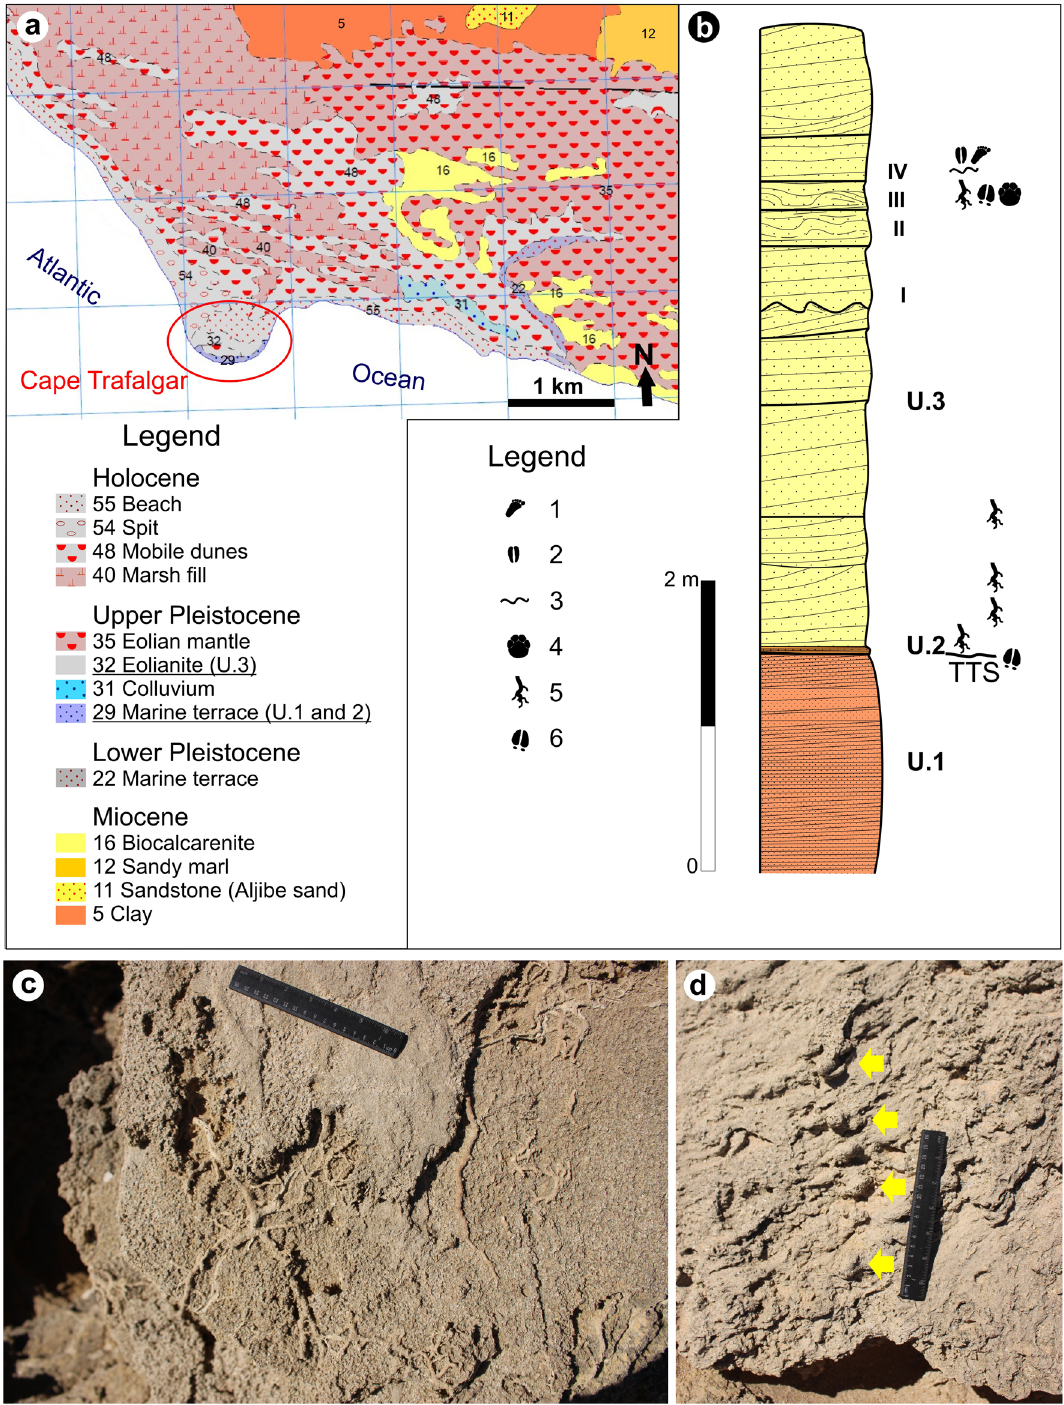
Figure 2. Stratigraphy of the TTS in Cape Trafalgar (Province of Cadiz). ( a ) Geological map of the Cap Trafalgar area (adapted from the Geological Map of Spain 1:50,000, Map no.1073 Vejer de la Frontera44, source: “© Geological Survey of Spain (IGME)”; ( b ) detailed stratigraphic column of Cape Trafalgar transition between beach and dune facies and location of the TTS and other trampled horizons (I–IV); rhizolith horizons corresponding to incipient paleosols are indicated (legend: 1—possible hominin footprint; 2—Pecoripeda isp.; 3—bioturbated lamina; 4—large footprint related to Palaeoloxodon antiquus ; 5—rhizoliths; 6— Bovinichnus uripeda ); ( c ) thin horizontal and densely branched rhizoliths from the second eolianite unit; ( d ) insect burrows in linear clusters preserved as convex hyporelief; ruler is 15 cm. Legend in ( a ), figure ( b ) and modifications to the photograph ( d ) have been made with CorelDraw 12 (https:// www. corel draw. com/